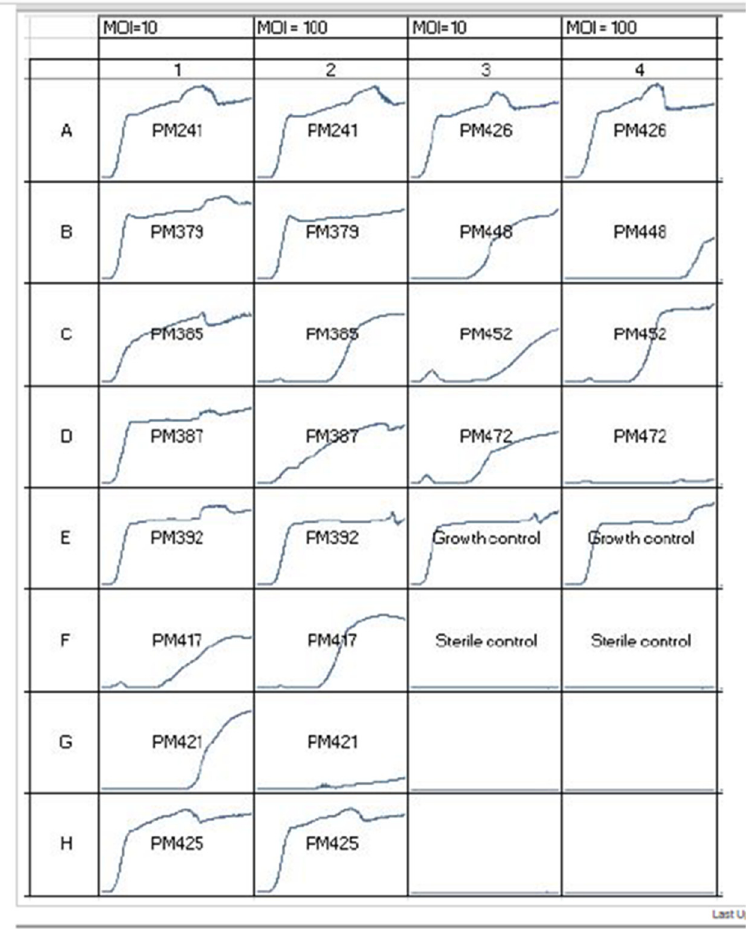
Figure 2. Bacterial growth inhibition curves or “Phagogram” for a compassionate use Staphylococcus epidermidis case in a recalcitrant prosthetic joint infection. Di ff erent bacteriophages are indicated by PM241-PM472. MOI refers to multiplicity of infection. Growth control is the bacterial isolate with no bacteriophages. Each box has time on the x -axis from 0 to 48 h. This figure shows how growth inhibition testing is conducted to determine potential bacteriophage candidates (PM448, PM472, and PM421). This figure also shows how di ff erent MOIs can cause di ff erent growth inhibition durations as seen with bacteriophages: PM448, PM472, and PM421.